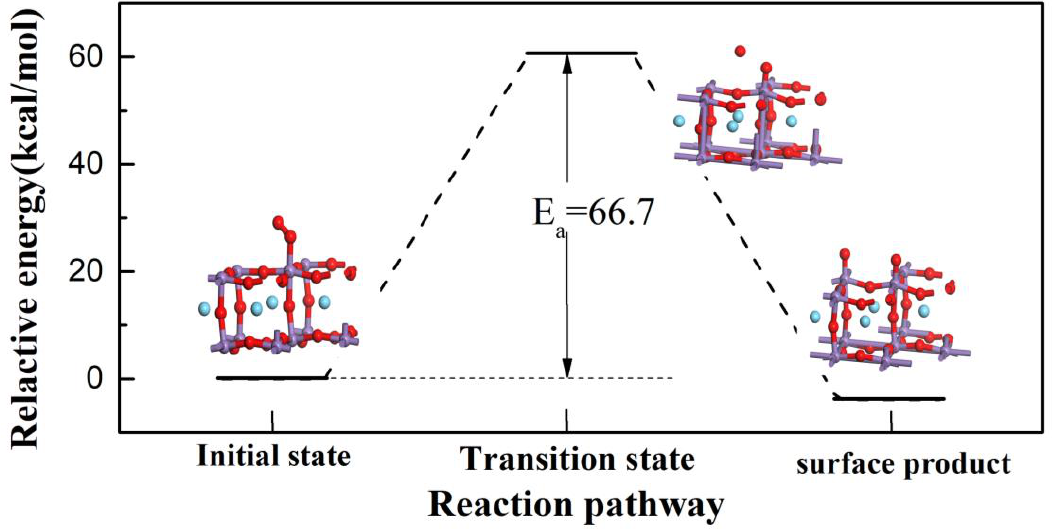
2 adsorption configuration.